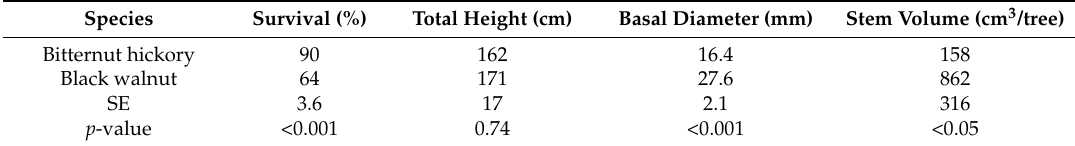
Table 1. Tree species effect on survival, height, basal diameter, stem volume of underplanted bitternut hickory and black walnut after 6 growing seasons in young forest stands (all trees protected with shelters). SE = standard error of the mean.